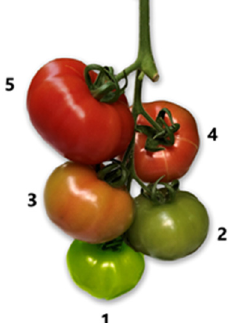
Figure 2. Tomato cluster with fruits in different growth/maturation phases according to external coloration: ( 1 ) green (fruit growth), ( 2 ) dark green (green, breaker ripeness classes), ( 3 ) light orange (turning, pink ripeness classes), ( 4 ) dark orange (light ‐ red ripeness class), and ( 5 ) red (red ripeness class).